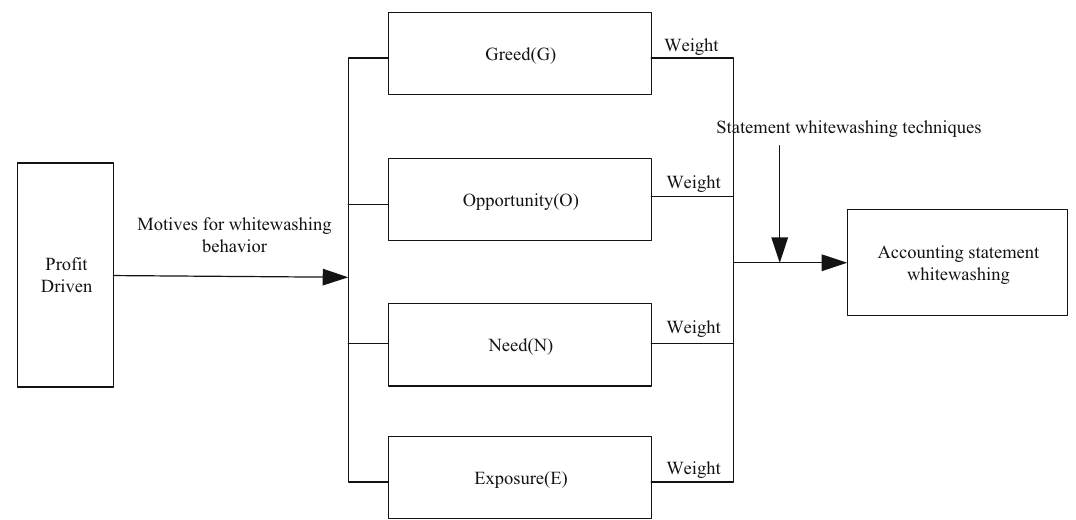
Figure 1: GONE theoretical framework of accounting statement whitewashing